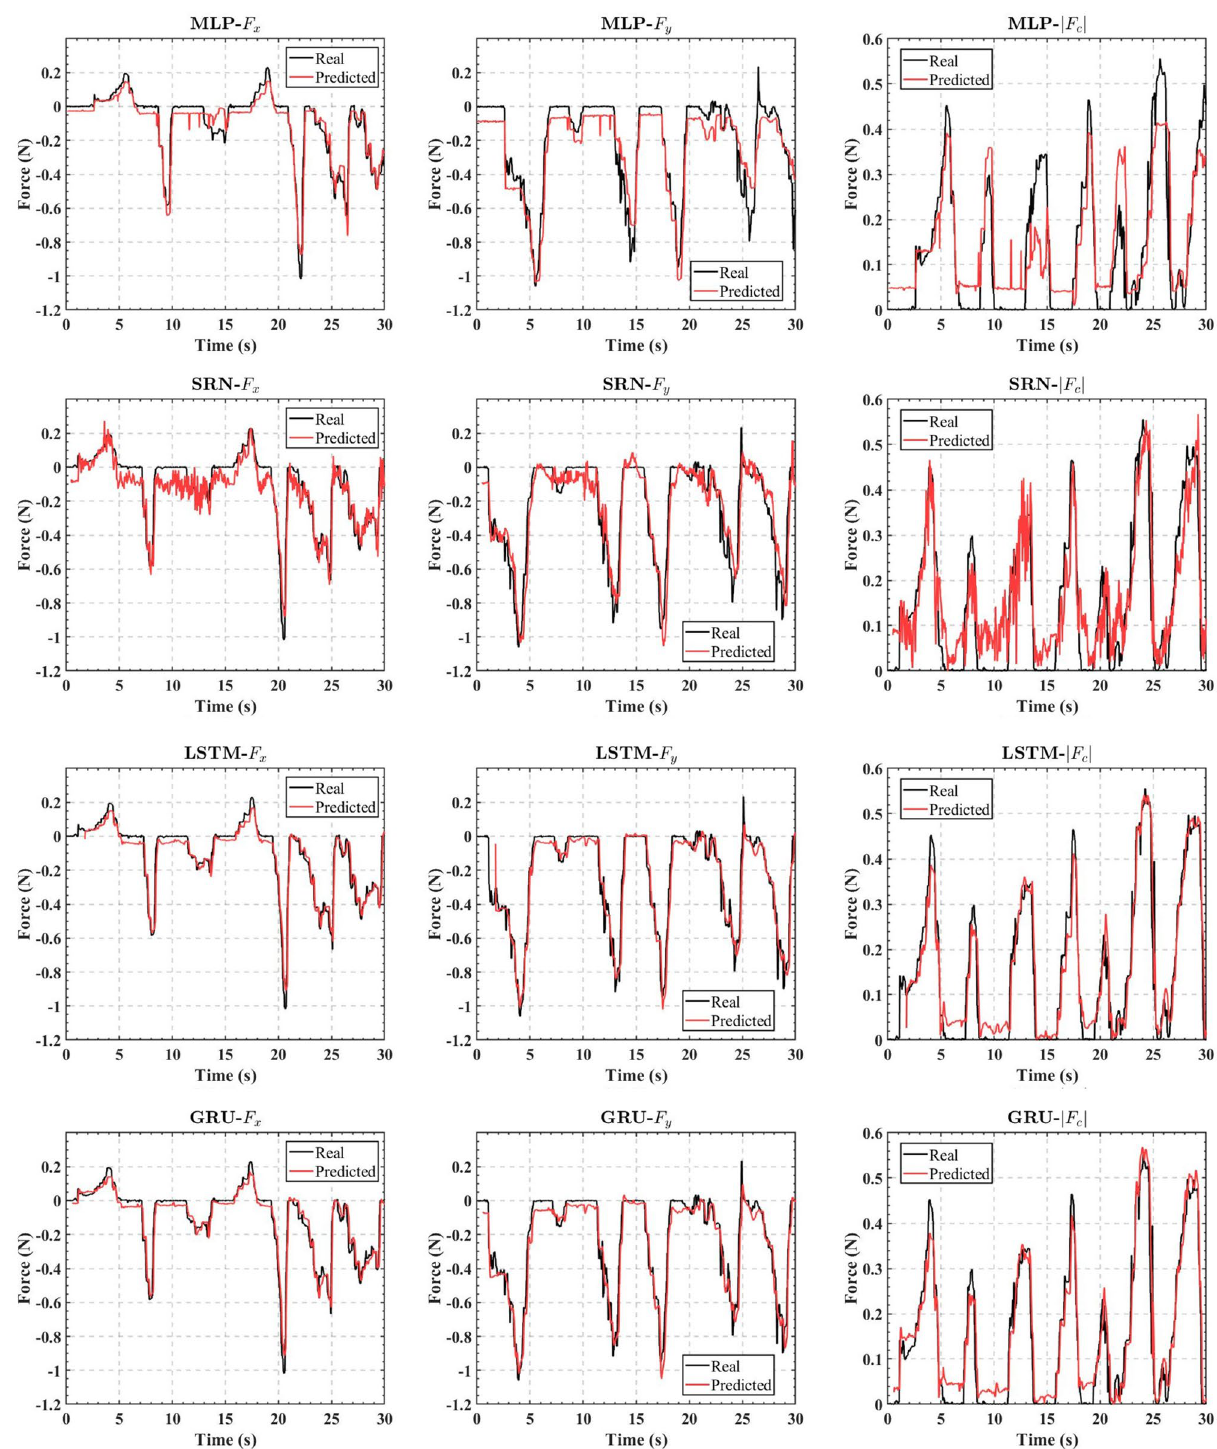
Figure 7. Dynamic performances of the real-time force